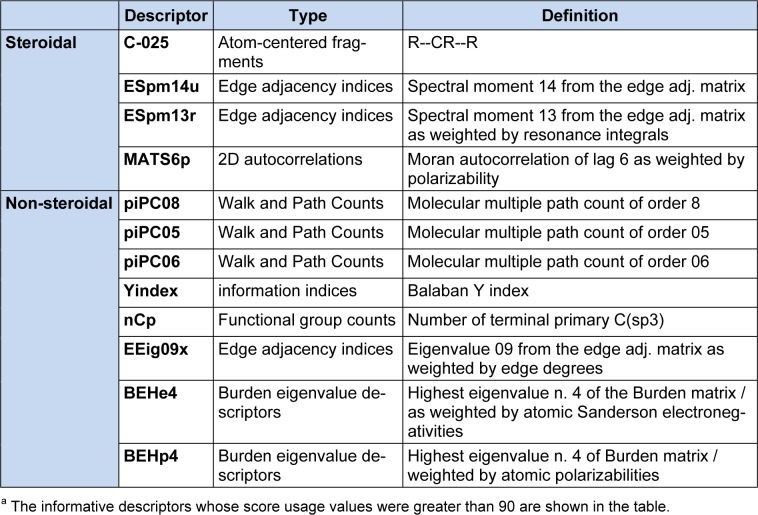
Definition of informative molecular descriptorsa of steroidal and non-steroidal AIs